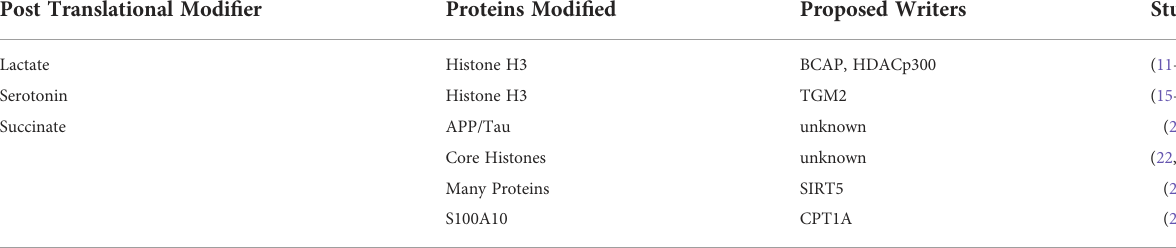
TABLE 1 Recent metabolite-based post-translational modi fi ers of